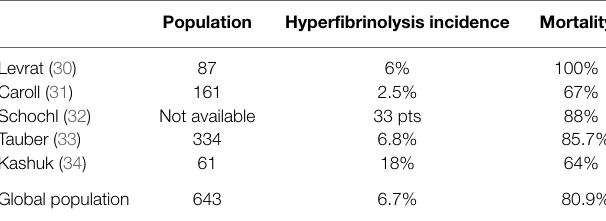
TABLE 3 | The occurrence of trauma-associated hyperfibrinolysis . Population Hyperfibrinolysis